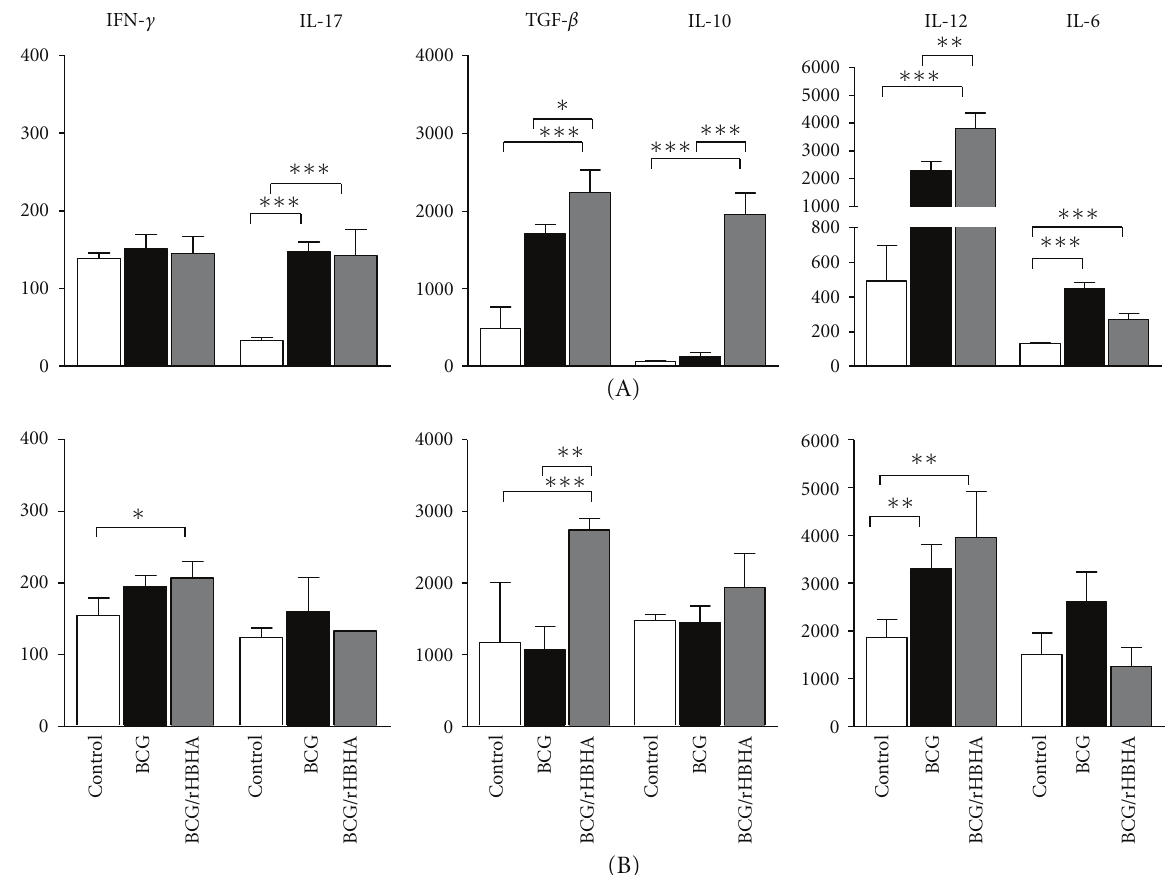
Figure 2: Lung cell cytokine profile of BCG-vaccinated mice with or without rHBHA boost after M. tuberculosis infection. Eight weeks after i.n. (A) or aerosol (B) challenge lung cells from control mice (white bars), BCG-vaccinated mice (black bars), or BCG-vaccinated/rHBHA- boosted mice (gray bars) were cultured in the presence of medium only, ConA (2.5 μ g/mL), or rHBHA (5 μ g/mL). Levels of cytokines were measured after 72h culture in the supernatants by using the OptEIA kit (BD Biosciences).Values are expressed in pg/mL and represent media ± SEM of samples tested in duplicates from each group of mice. Statistically significant data: P < 0 . 05 ( ∗ ), P < 0 . 001 ( ∗∗ ), and P < 0 . 0001 ( ∗∗∗